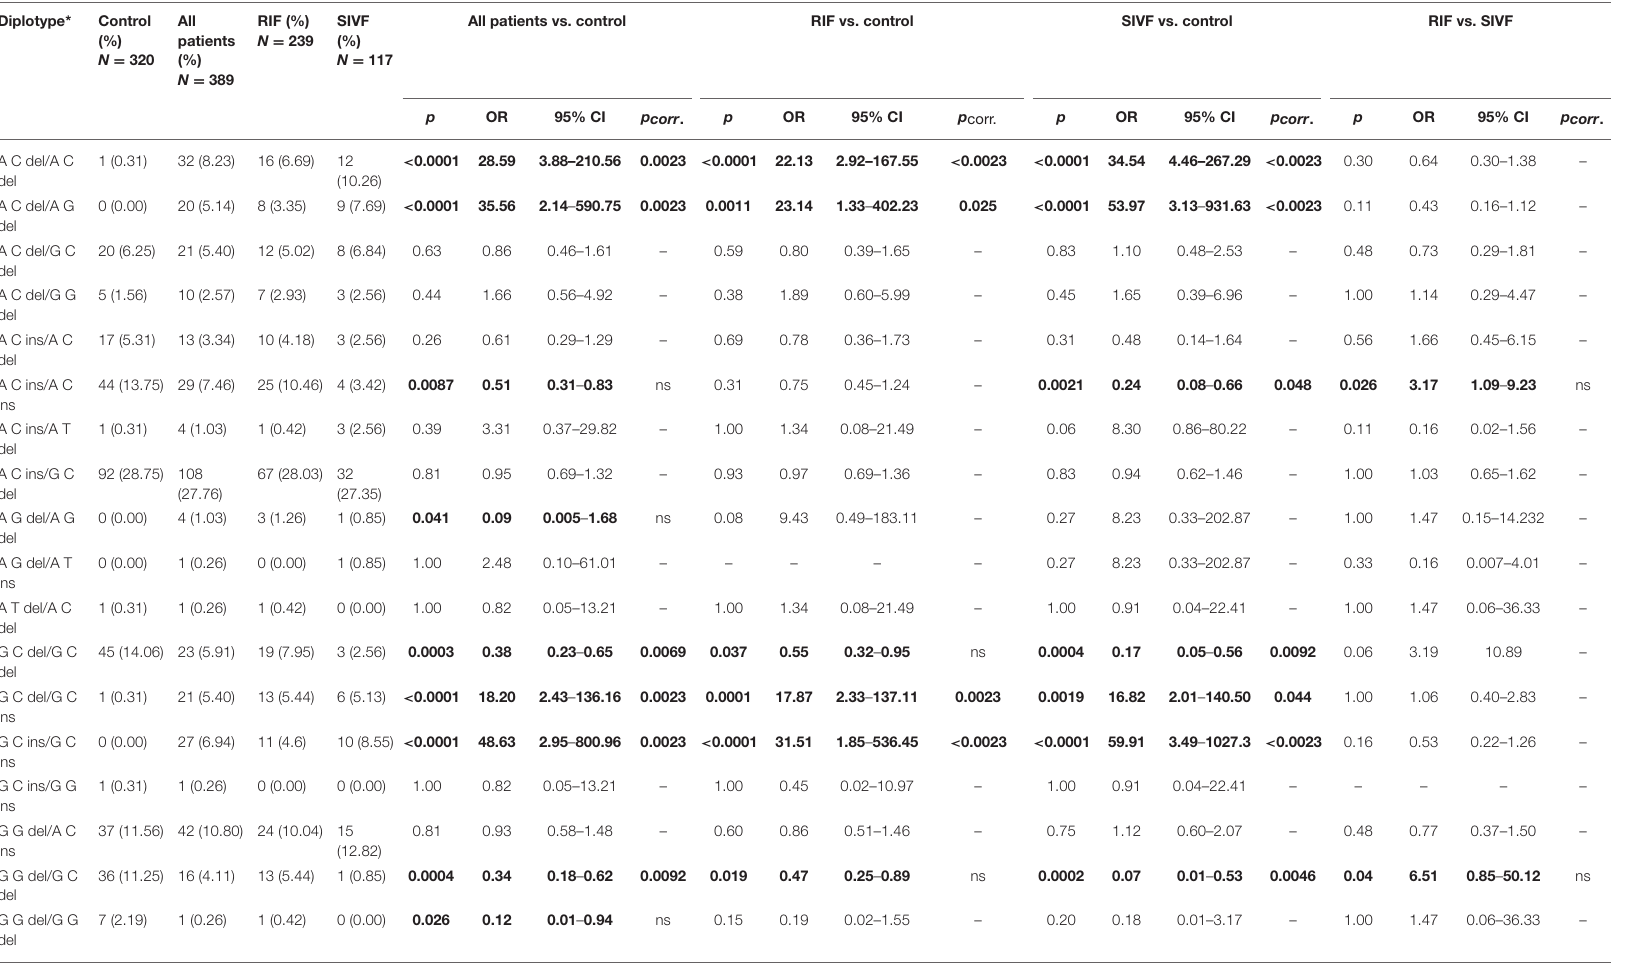
TABLE 4 | HLA-G diplotype frequencies in women from control and patient